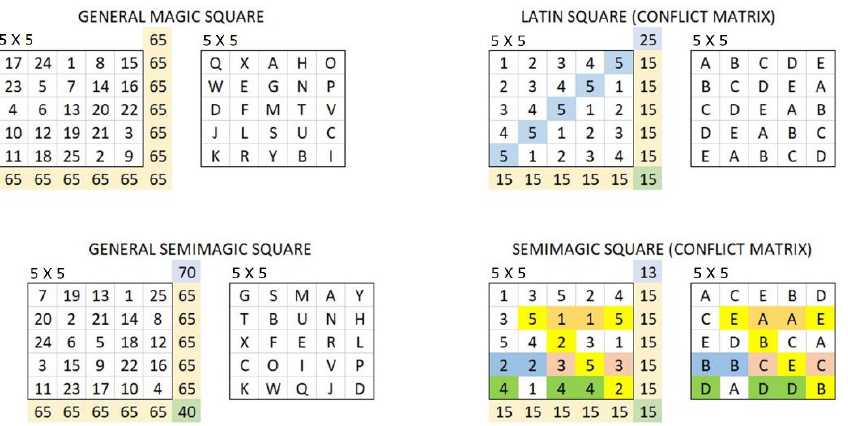
Figure 1. Different types of magic squares.